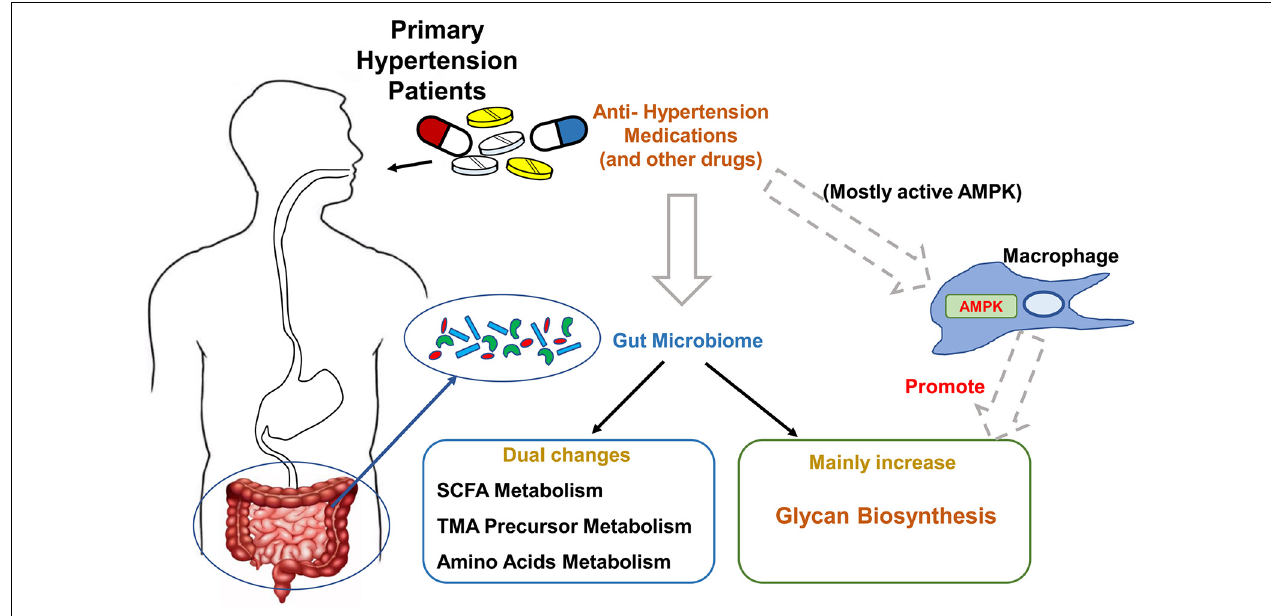
FIGURE 6 | Summary of the major findings of this study. The major changes of gut microbiome in primary hypertension patients taking antihypertension medications, and potential regulating mechanism by macrophage–adenosine monophosphate-activated protein kinase (AMPK) are summarized in this schema.